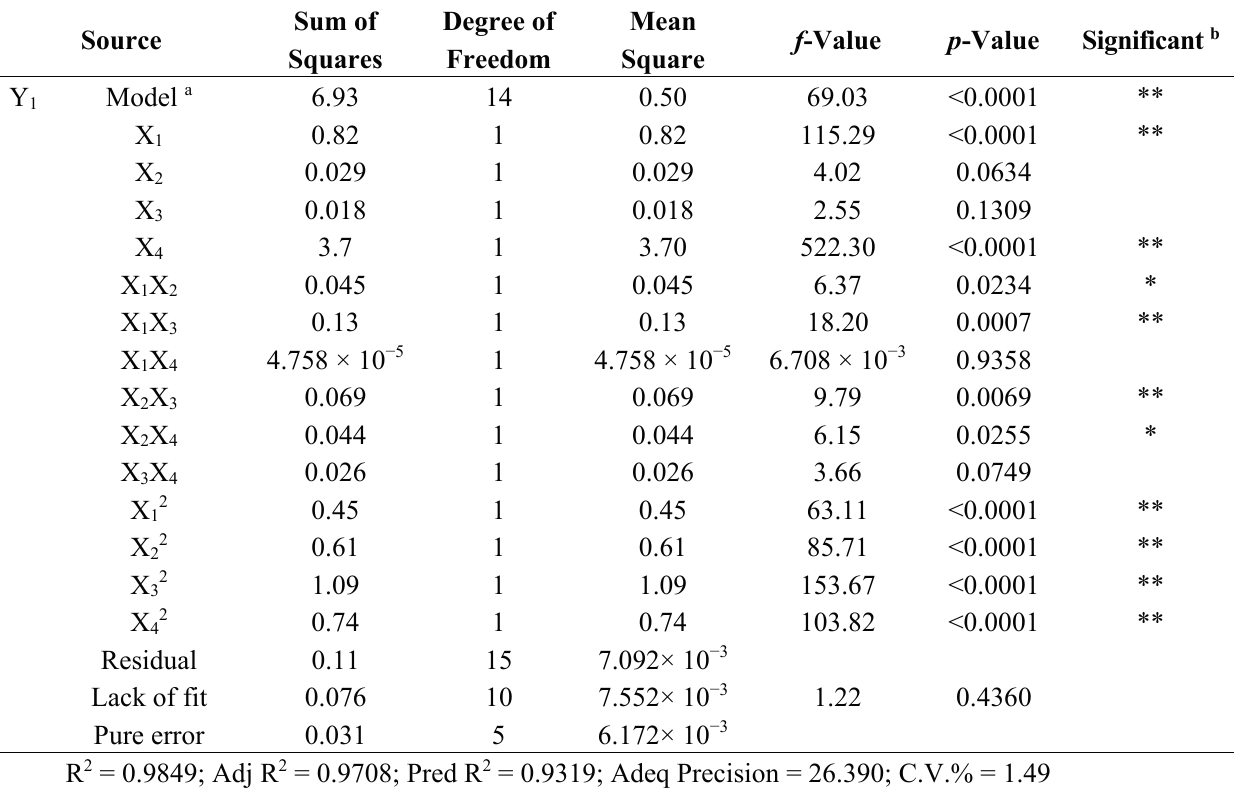
Table 3. Analysis of variance results for the multiple regression to predict